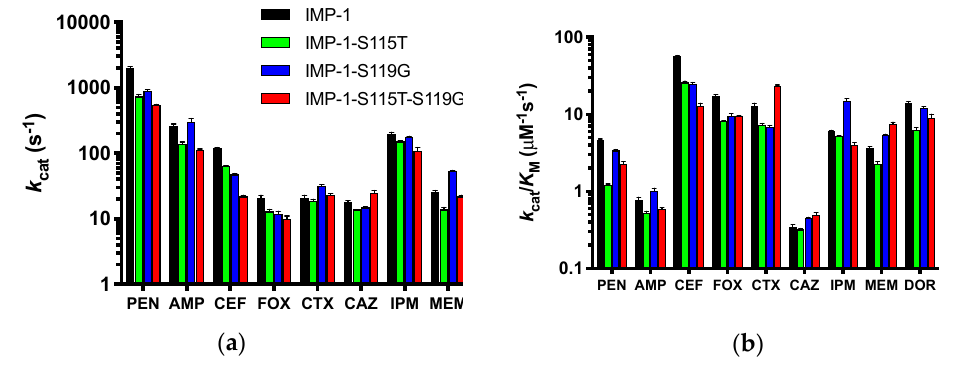
Figure 5. Graphical representation of the kinetic constants of the four enzymes against a panel of antibiotics spanning penicillins, cephalosporins, a cephamycin, and carbapenems. The monobactam aztreonam was not converted and is not included. The abbreviations of antibiotics are as in Figure 2. Columns are colored by enzyme variant as shown in the legend in Panel (a). ( a ) Turnover numbers k cat . ( b ) Catalytic efficiencies k cat / K M . The y-axes are shown in log scale to facilitate comparison of all antibiotics.